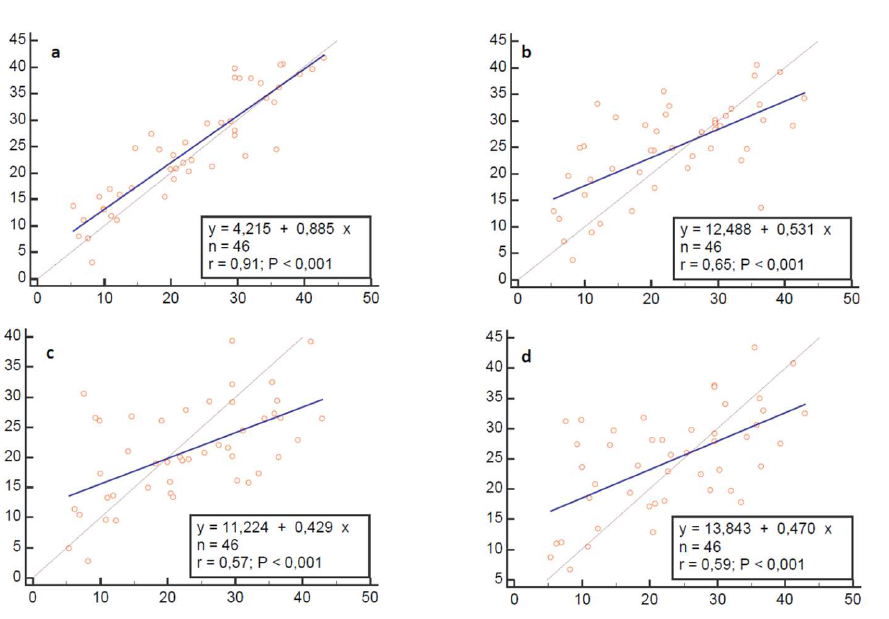
Figure 4. Linear regression analysis plots. Regression model: Alternative method (y) = a + b (Venco classic). Blue line represents line of equality (y = x). ( a ), Venco te-le; ( b ), Visser classic; ( c ), Visser le-le; ( d ), Visser te-le.